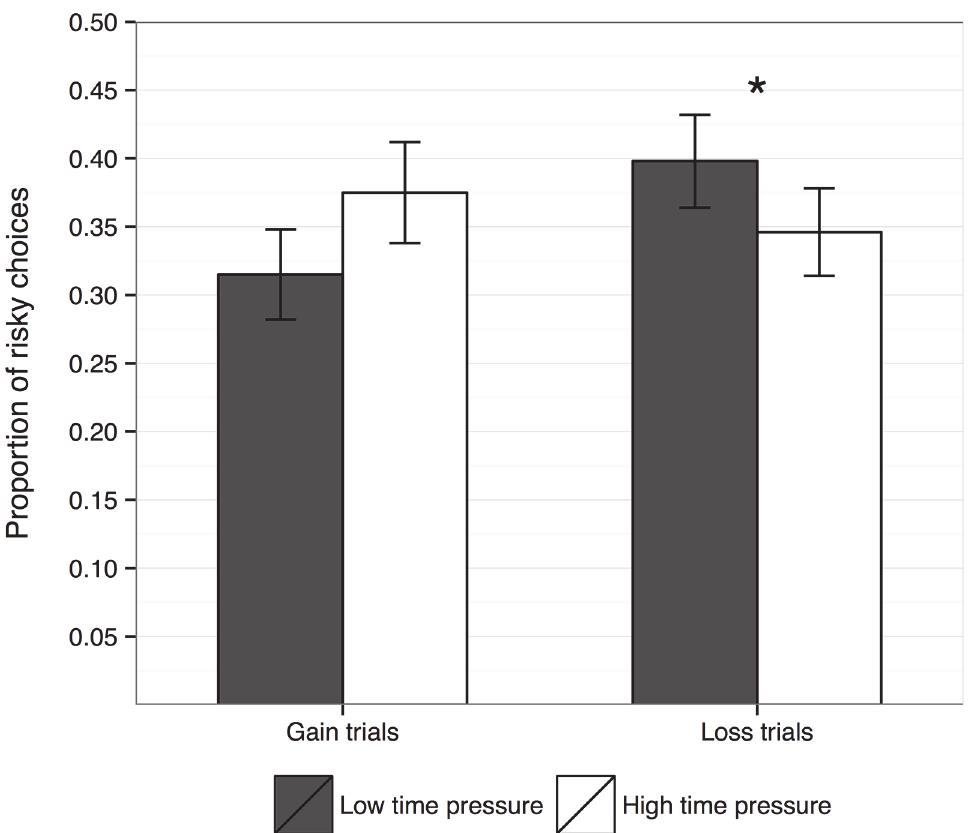
Fig 1. Experiment 1 — Proportion of risky choices taken as a function of the choice framing (gains vs. losses) and the time-pressure condition. Error bars indicate standard errors of the mean.